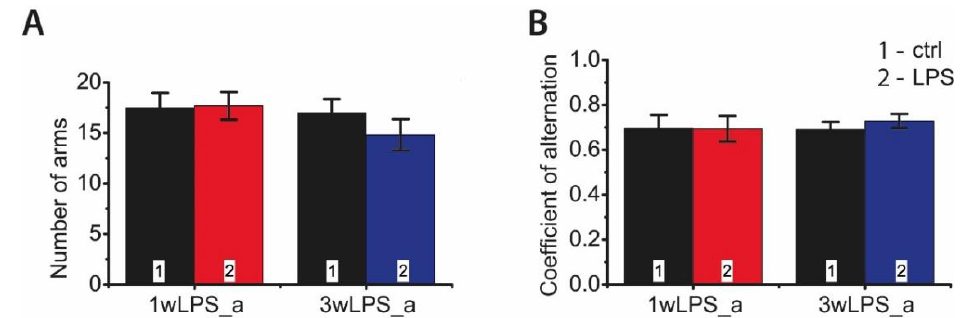
Figure 10. The behavior of P90 rats in the Y-maze test, which were treated with LPS in early postnatal ontogenesis. ( A ) Number of visited arms (interaction time × treatment: F 1,38 = 0.66; p = 0.42; time: F 1,38 = 1.34; p = 0.25; treatment: F 1,38 = 0.49; p = 0.49). ( B ) Coefficient of alternation (interaction time × treatment: F 1,38 = 0.19; p = 0.67; time: F 1,38 = 0.11; p = 0.74; treatment: F 1,38 = 0.16; p = 0.70).